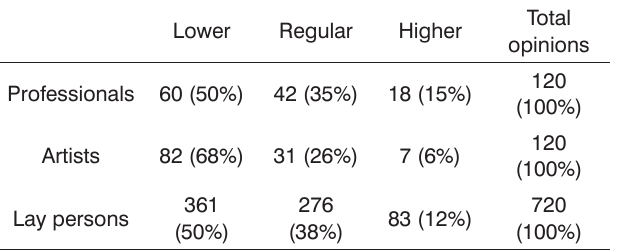
Table 1. Best profile per interviewee group Lower